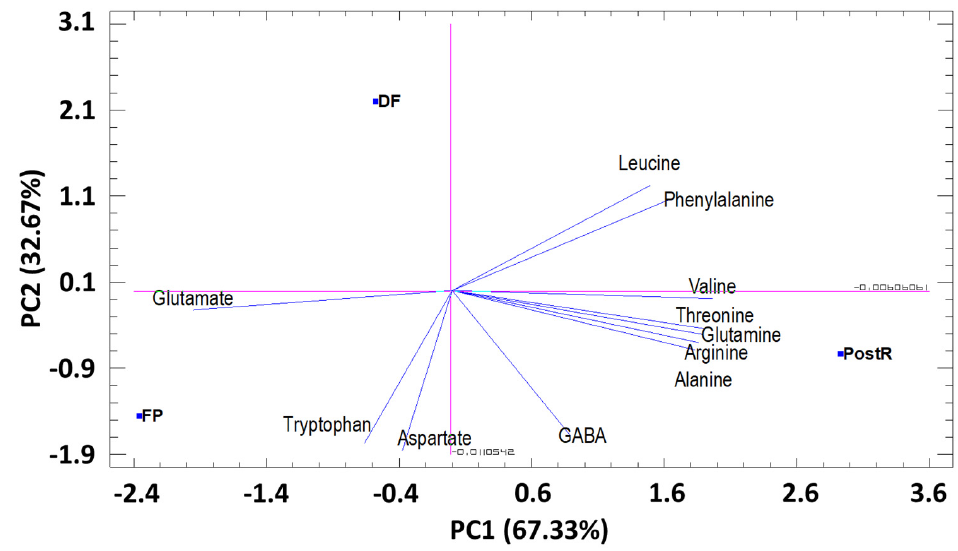
Figure 4. Principal components analysis (PC1 and PC2) for amino acids identified in pomegranate leaves cultivated in three different phenological stages. PC1 (65.85) and PC2 (34.16%).